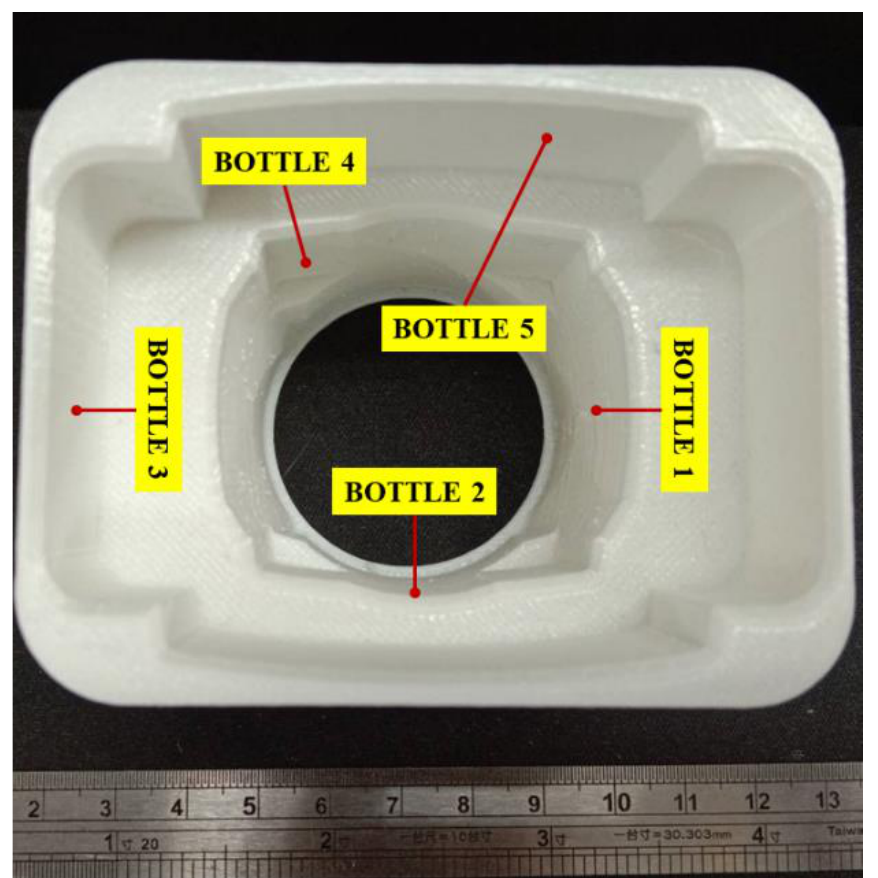
Figure 10. Top view of the printed universal puck with slots for five bottles. The performance of the universal pucks is evaluated in the third stage of the